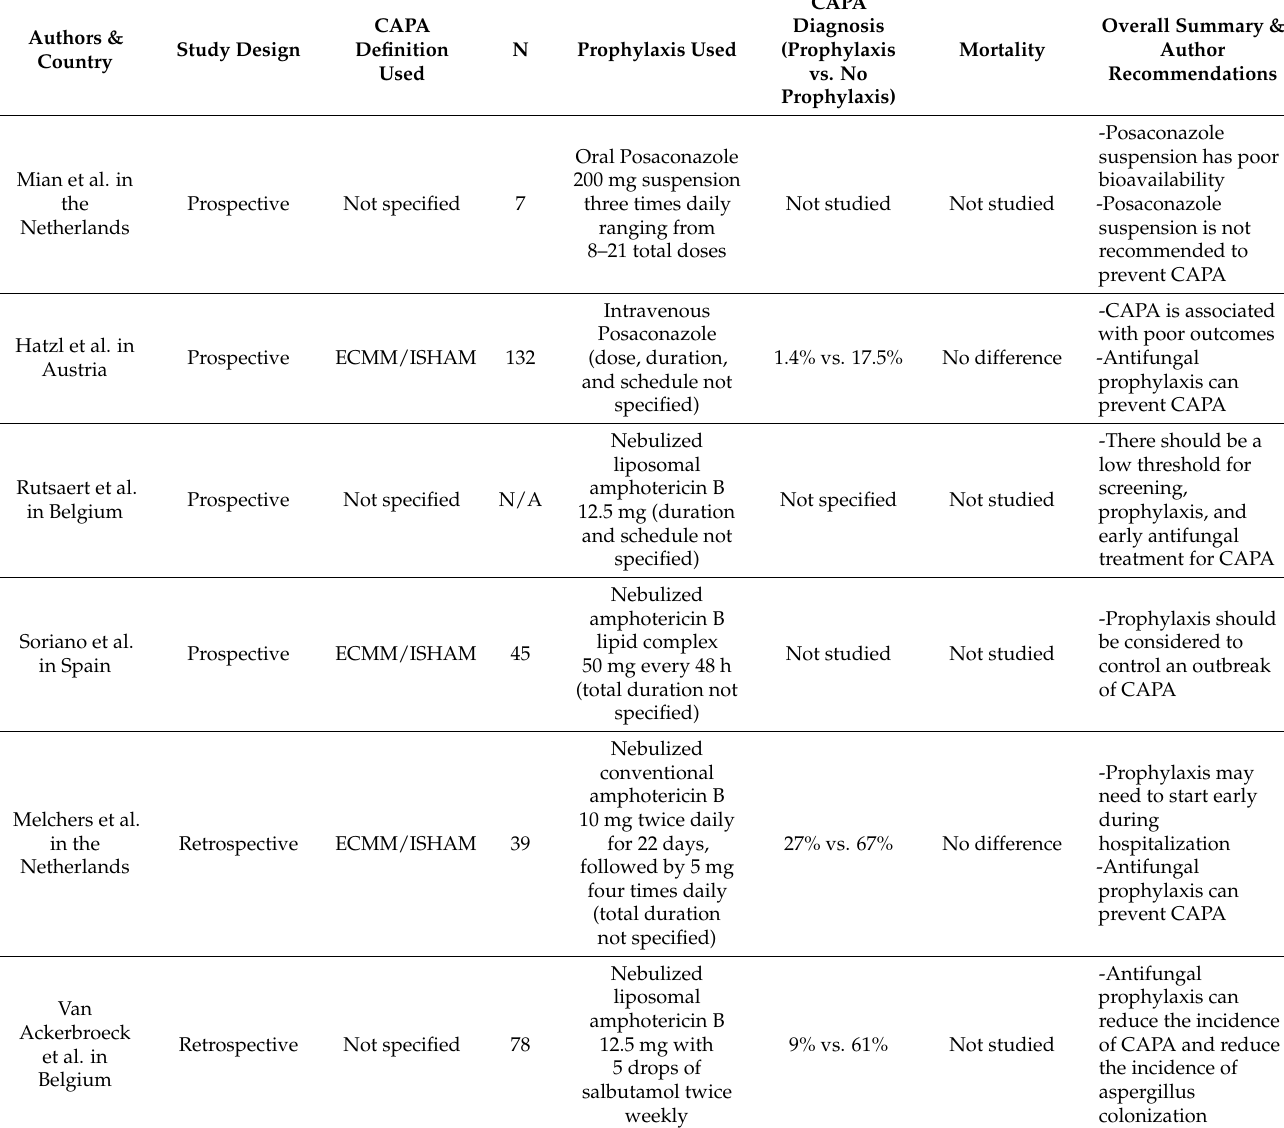
Table 1. Summary of existing studies on antifungal prophylaxis for